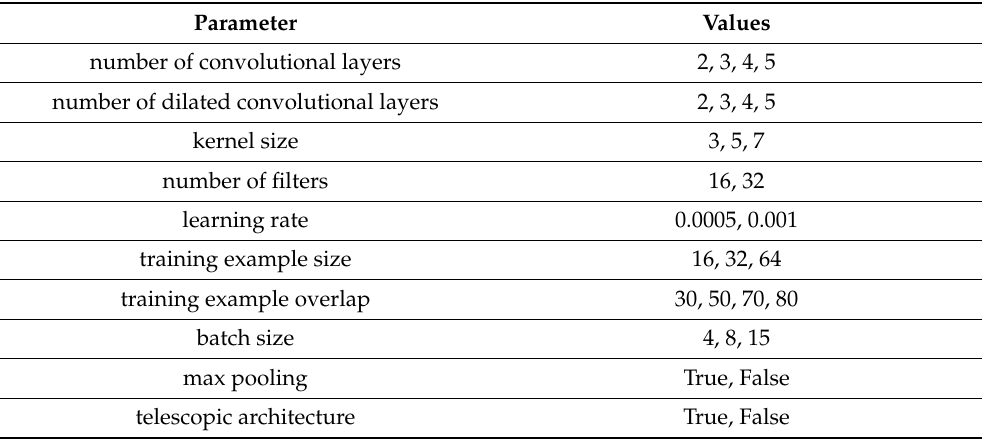
Table 1. Hyperparameters considered during the